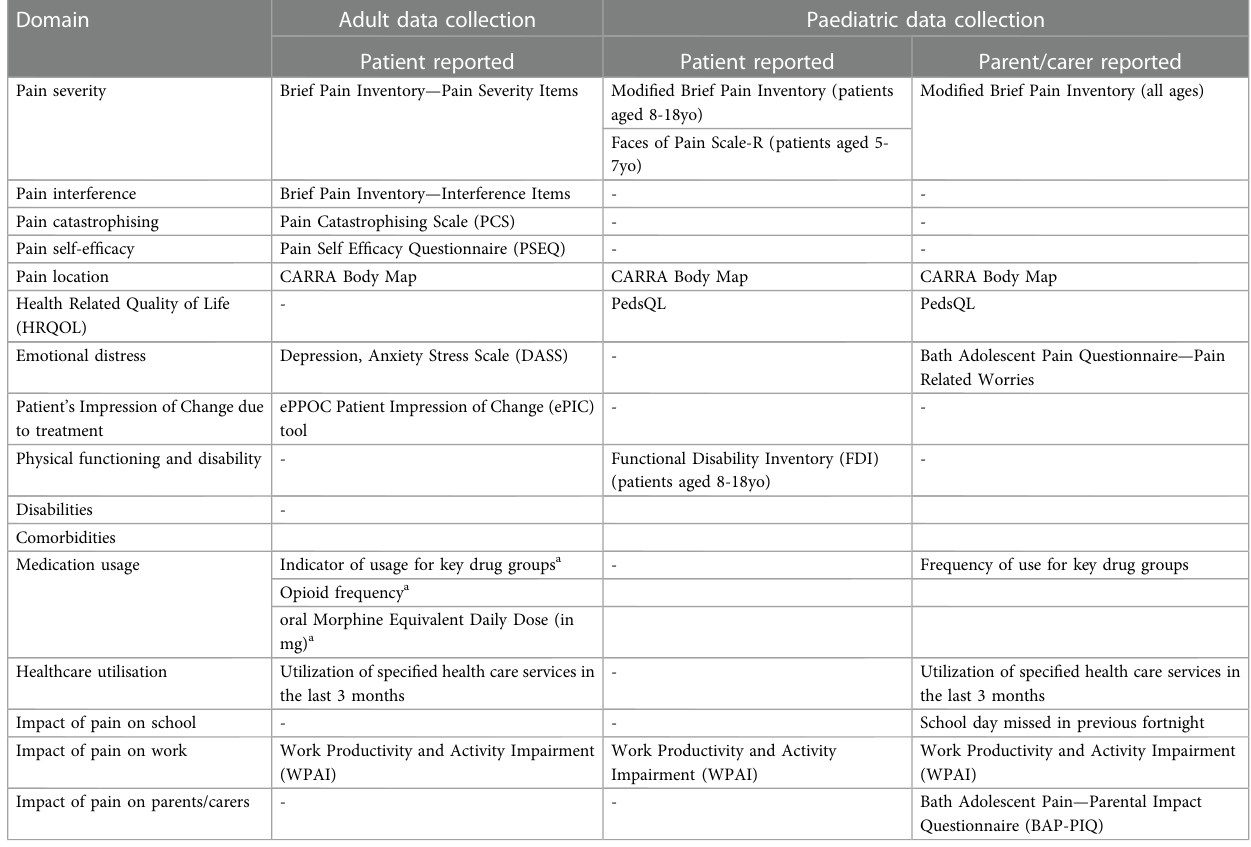
TABLE 2 Patient/carer reported measures for the adult and paediatric data